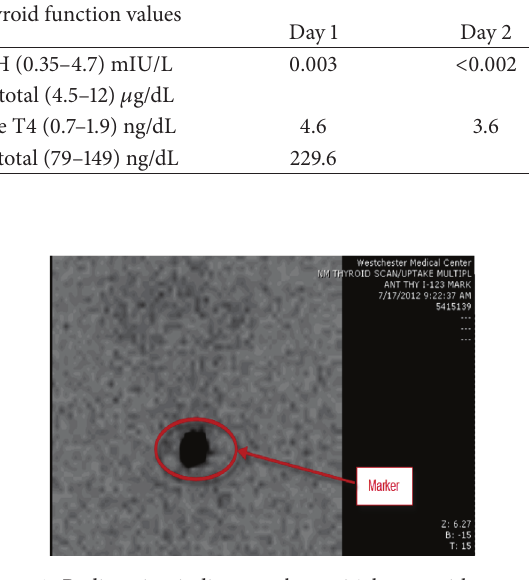
Figure 1: Radioactive iodine uptake at 24 hours with very low uptake in thyroid